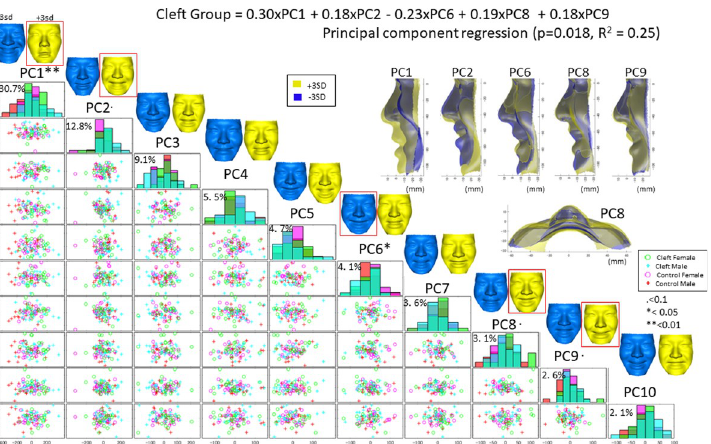
Fig 6. A scatter plot matrix of the principal component (PC) scores in the Cleft and Control groups with a histogram in the diagonal cells. PCs 1–10 explain 78.3% of the shape variation across samples. Green denotes facial configurations in the female Cleft group, cyan denotes those in the male Cleft group, pink denotes those in the female Control group, and red denotes those in the male Control group. The PCs are defined as +1 SD (yellow) and − 1 SD (blue) in the top column. For example, the top column indicates that a +3 SD value of PC1 represents a smaller facial displacement while smiling, shown in yellow (+3 SD). The histogram shows that the bimodal distribution and patients in the Cleft group (cyan) showed a greater PC1 value than the Control group, suggesting that the Cleft group had a smaller facial displacement while smiling. The red squares show PCs that were representative of the Cleft group based on the PC regression analysis (P < 0.1).